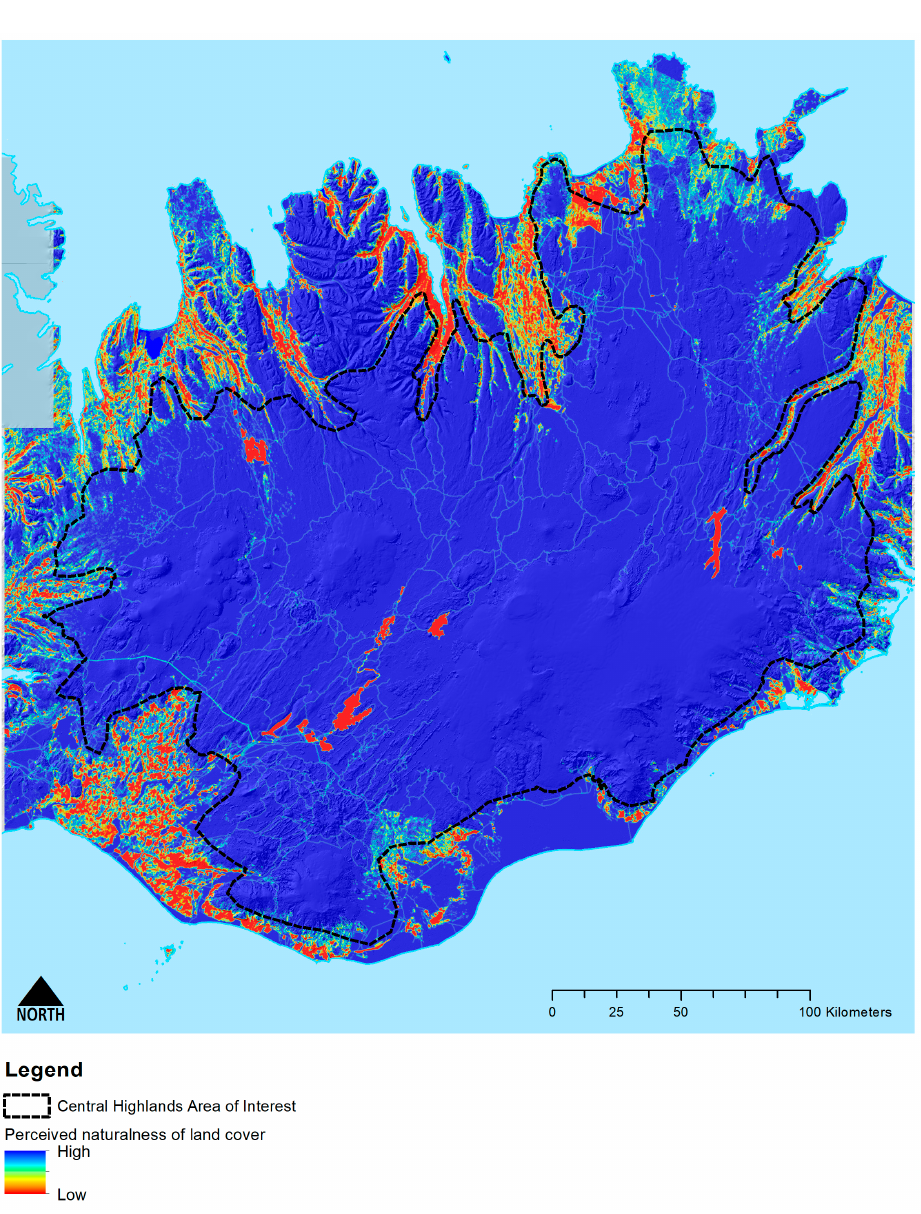
Figure 5. Perceived naturalness of land cover .